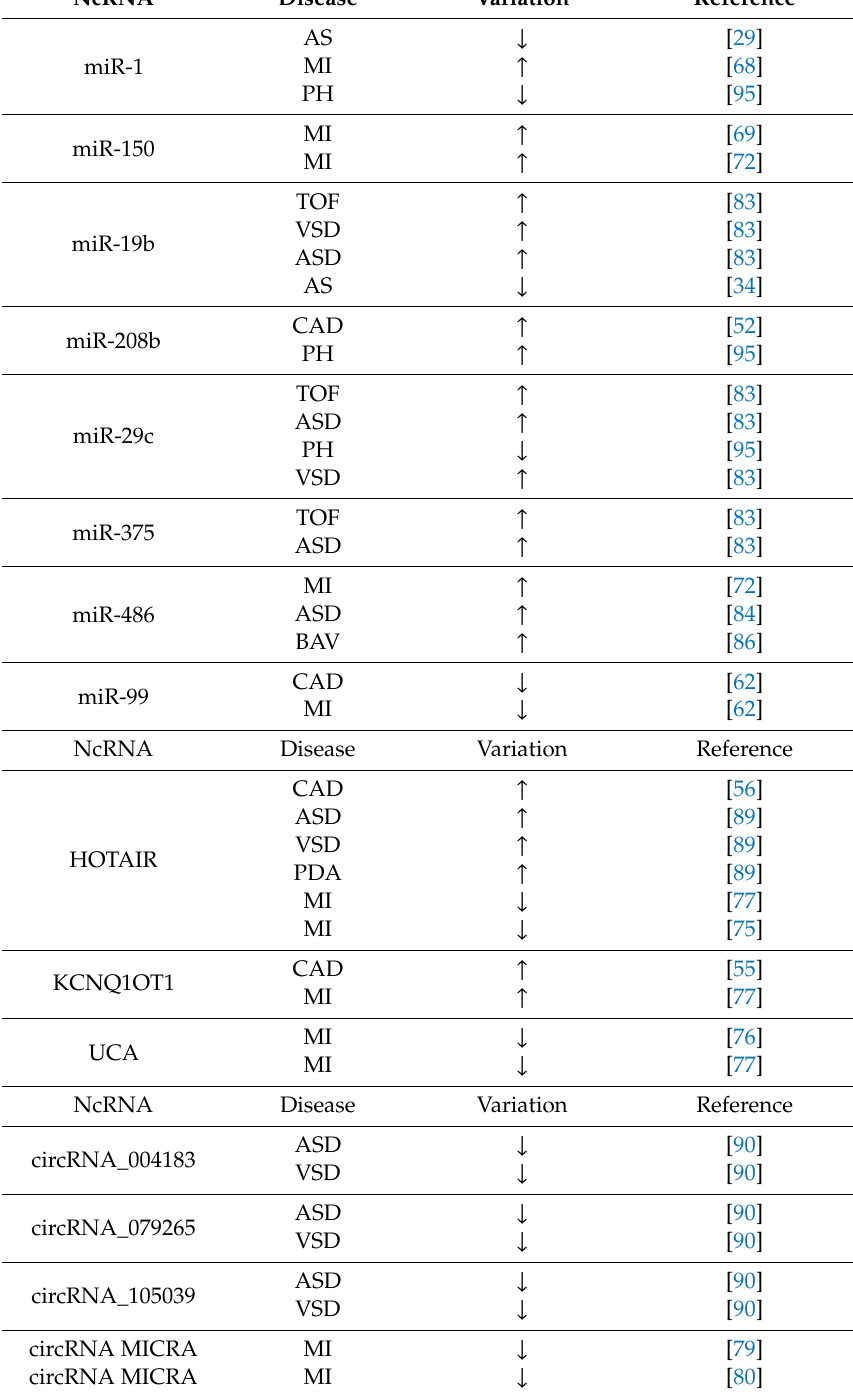
Table 1. List of non-coding RNAs (miRNAs, lncRNAs, and circRNAs) involved in multiple cardiovascular diseases. AS, aortic valve stenosis; MI, myocardial infarction; PH, pulmonary hypertension; TOF, tetralogy of fallot; VSD, ventricular septal defect; ASD, atrial septal defect; PDA, patent ductus arteriosus; BAV, bicuspid aortic valve disease; CAD, coronary artery disease. Arrows indicate the direction of miRNA variation: ↓ and ↑ correspond to a under-expression and over-expression of the